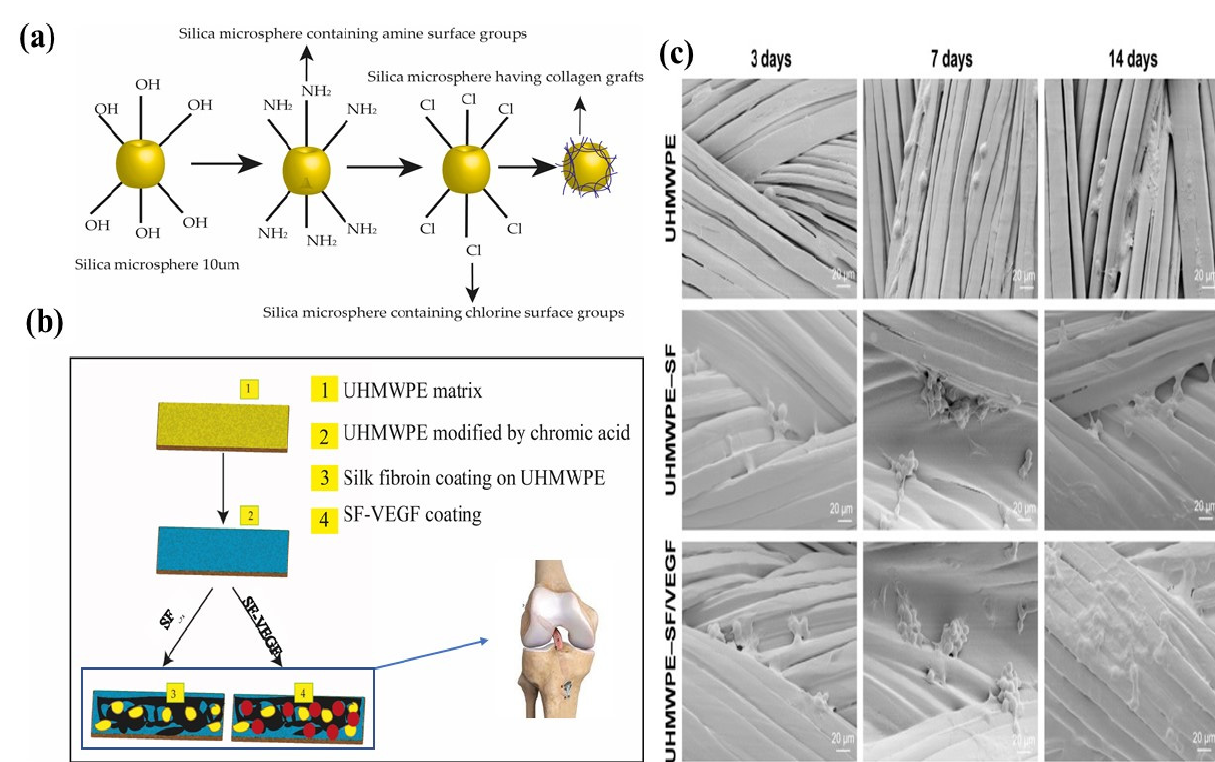
Figure 13. ( a ) Bioactivity of bioglass; ( b ) schematic preparation of SF/VEGF coating [37]; ( c ) mor- phology of different groups of UHMWPE [37].